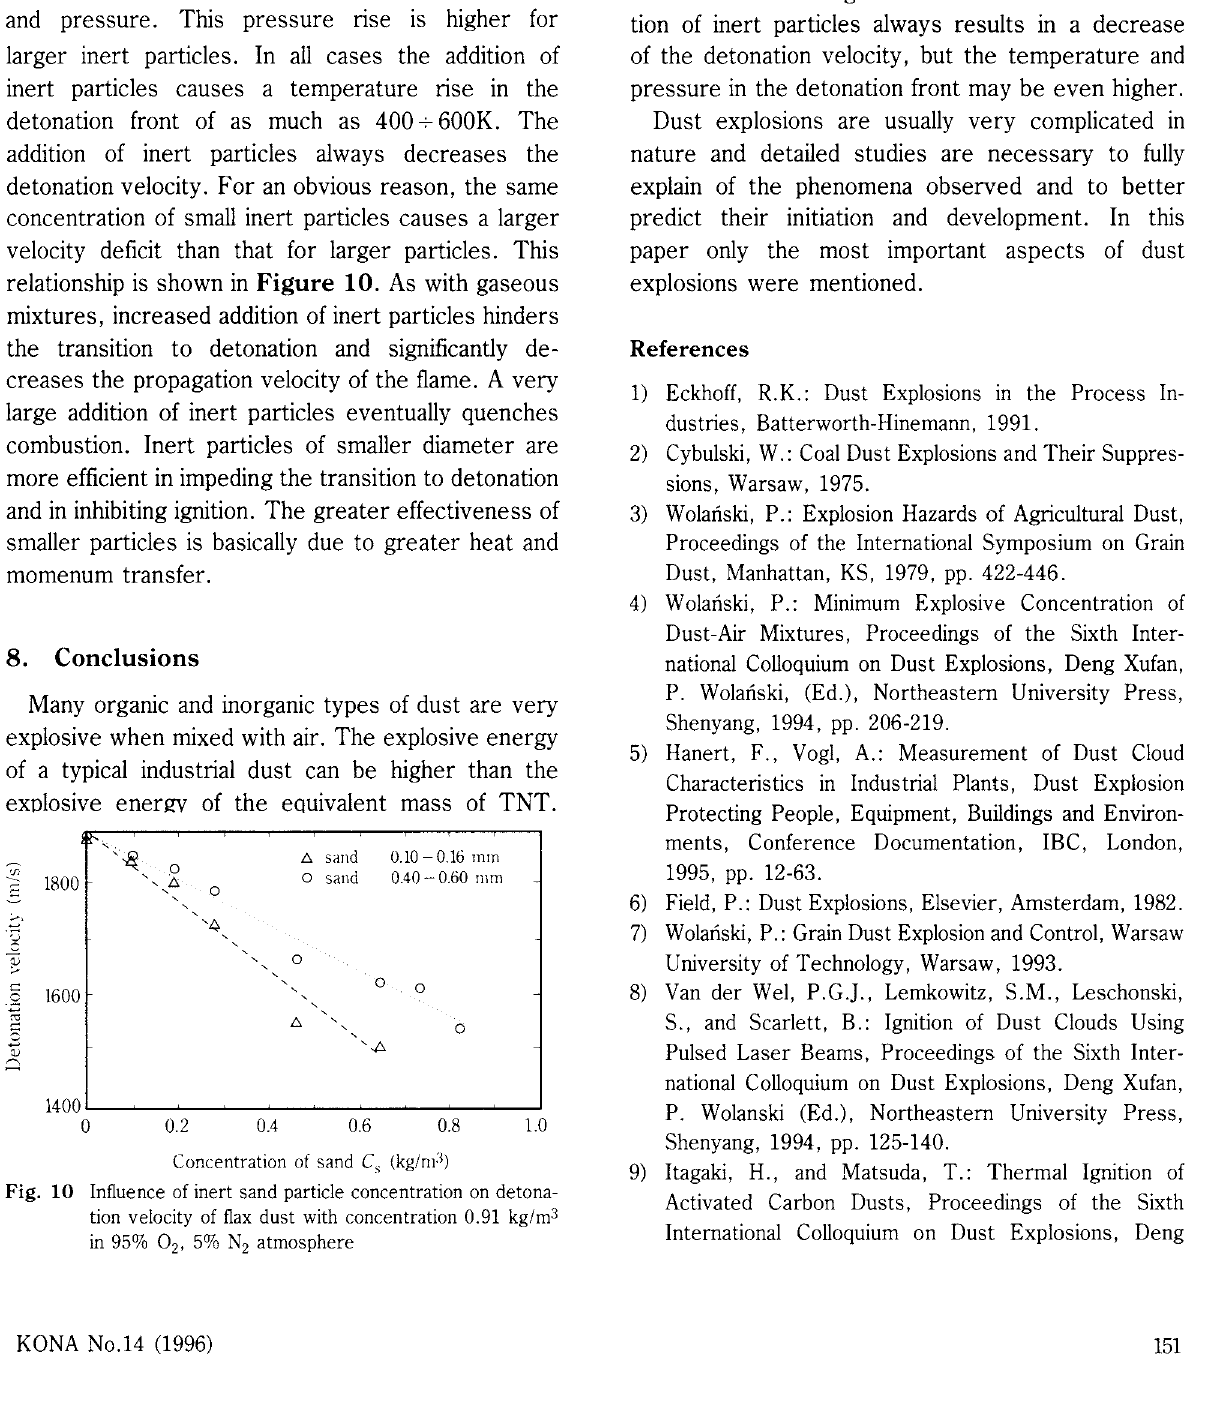
Fig. 10 Influence of inert sand particle concentration on detona tion velocity of flax dust with concentration 0.91